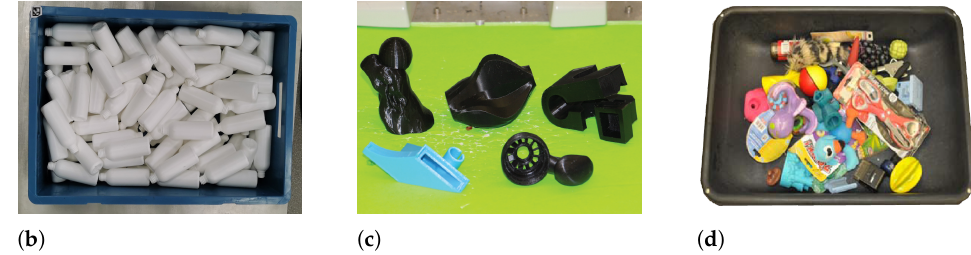
Figure 3. Some of the possible combinations of different conditions: ( a ) single object [35]; ( b ) multi- ple, similar and overlapping objects [36]; ( c ) complex, multiple, different and divided objects [37], ( d ) multiple, different and overlapping objects